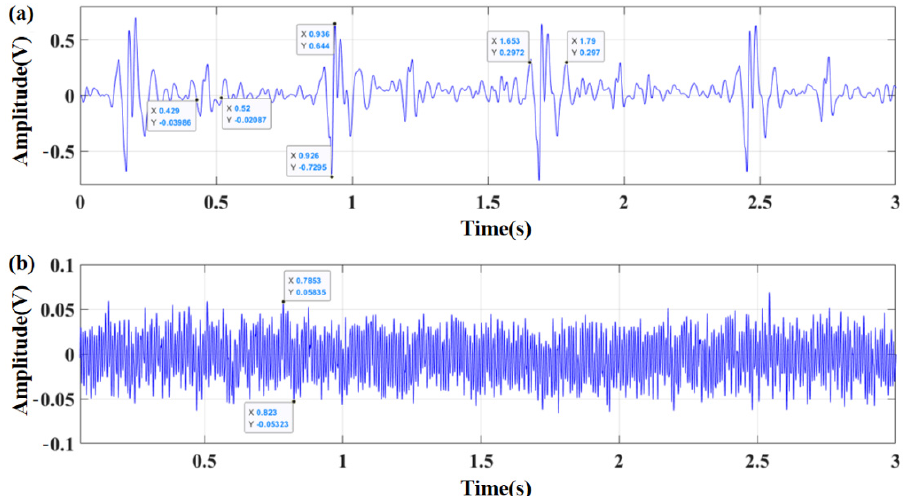
Figure 15. ( a ) The heart sound test results for 3M Littmann 3200 stethoscope; ( b ) the static noise